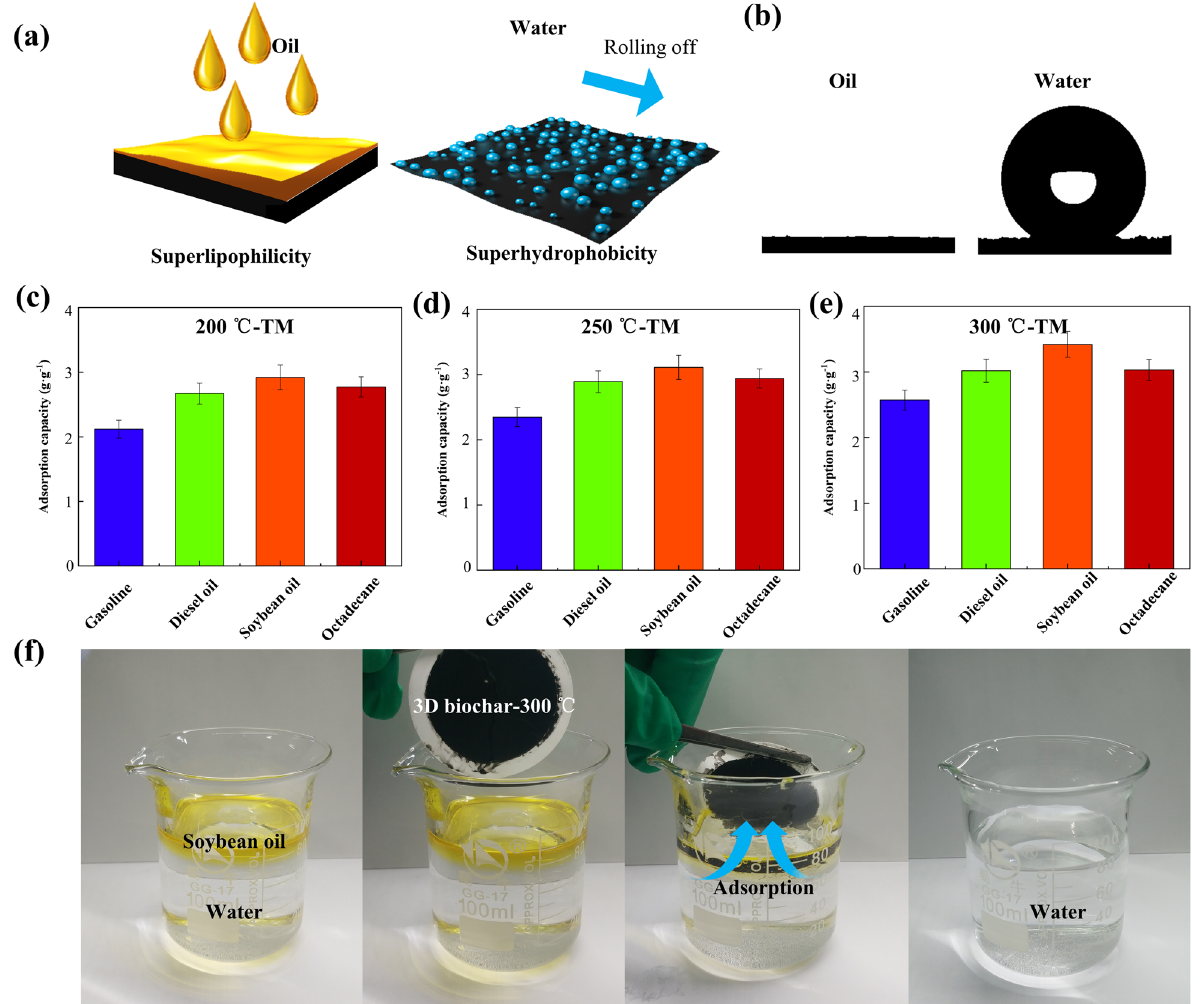
Fig. 4 a , b Superlipophilicity and superhydrophobicity of microalgal biochar, c – e oil adsorption capacity of different microalgal biochar, and f process of adsorption and separation of oil from water using the microalgal